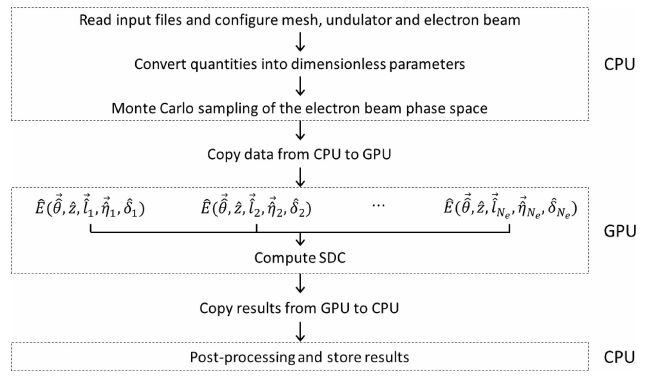
Figure 1 General workflow of FOCUS